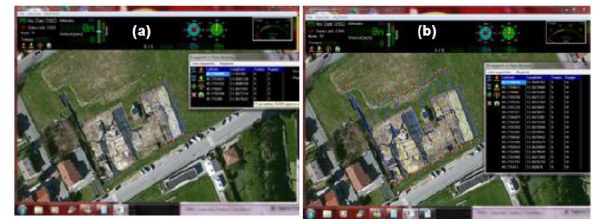
Figure 5. The planned flights input inside the control unit: lowest flight (a) and highest flight (b)